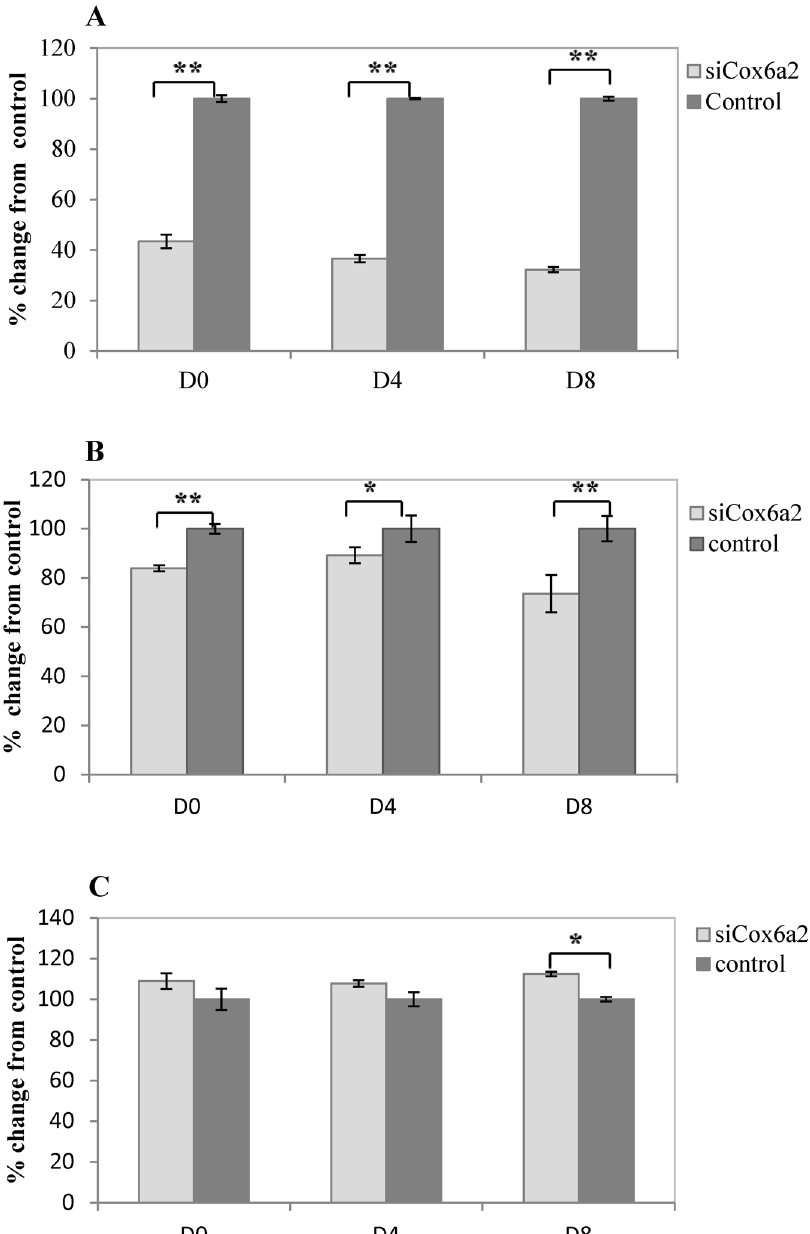
Fig 9. Knockdown of Cox6a2 by RNA interference reveals regulation of ATP levels. siRNAs were designed to target Cox6a2 and transfected into murine C2C12 muscle cells in vitro. Relative mRNA expression of Cox6a2 was measured by qPCR 48 hours after transfection. Expression was normalized to Hprt1 and Ppia internal controls. (A) Expression of Cox6a2 was significantly reduced relative to its expression in control cells at 48 hours post-transfection of siRNA. (B) ATP levels and (C) ADP/ATP ratio were measured at D0, D4, and D8. All values are presented as mean ± SEM (n =